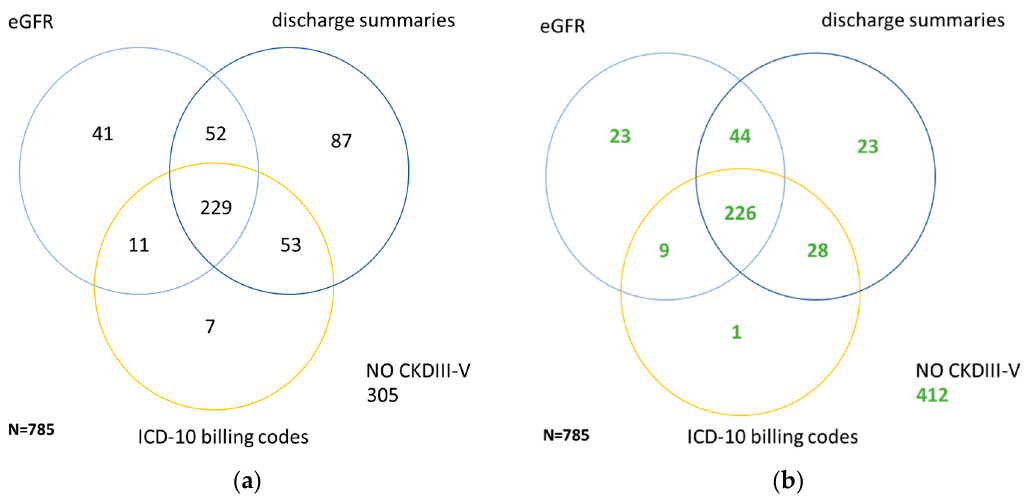
Figure 1. Venn diagrams comparing identification of CKD ≥ III by laboratory results (eGFR values), discharge summaries or ICD -10 billing codes within all patients ( a ) and within patients with CKD ≥ III according to reference standard ( b ). ( a ) Numbers of patients from the study cohort with CKD recognized by laboratory results (eGFR values), discharge summaries or ICD-10 billing codes. ( b ) Numbers of patients from the study cohort with CKD correctly recognized by laboratory results (eGFR values), discharge summaries or ICD -10 billing codes. A total of 19 patients were recognized by neither of the three formal criteria, but by manual review only. Table 2. Epidemiological characteristics from patients with CKD identified by reference standard